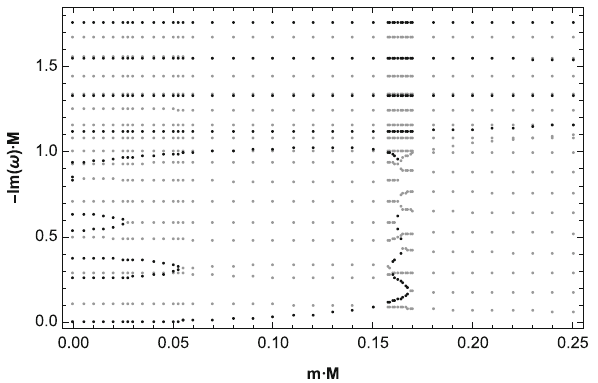
Fig. 9 The behavior of the imaginary part of the quasinormal frequen- cies − Im (ω) M as a function of the scalar field mass mM for different overtone numbers with (cid:5) = 0, M β = 0 . 20, and M 2 (cid:6) = 0 . 04. Black points for purely imaginary QNFs and gray points for complex QNFs. Here, different colors do not describe the families, except for mM = 0, wheretheblackpointscorrespondtothedSfamily,whilethegraypoints correspond to the photon sphere family. Then, in order to distinguish the family for mM > 0 it is necessary to connect it with mM = 0, where the different families have been